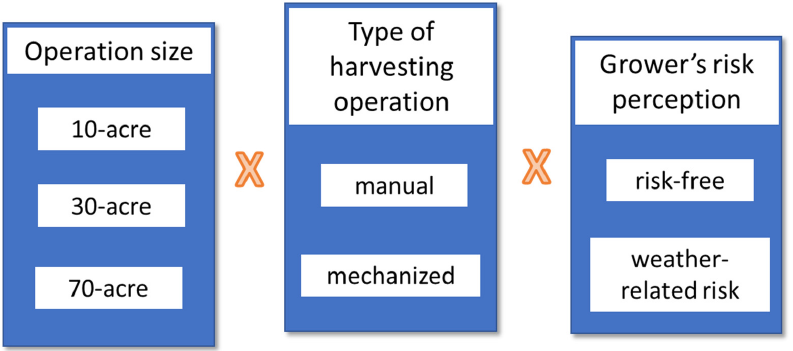
Figure 1. Combination of levels to generate scenarios for the feasibility analysis.